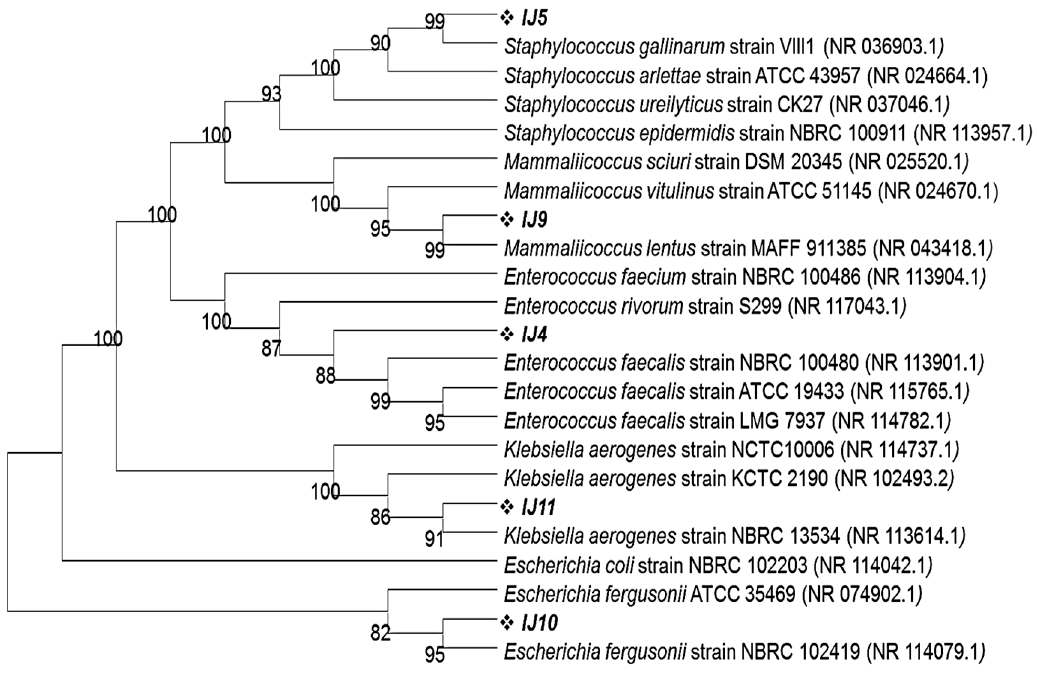
Figure 4. Phylogenetic tree showing the clustering of mice intestinal pathogens grown on CHRO- Magar plates on the basis of 16S rRNA gene sequences with their closely related homologs. The phylogenetic relationship was inferred using the neighbor-joining method by MEGA11 software program. The bootstrap consensus tree was inferred from 100 replicates.